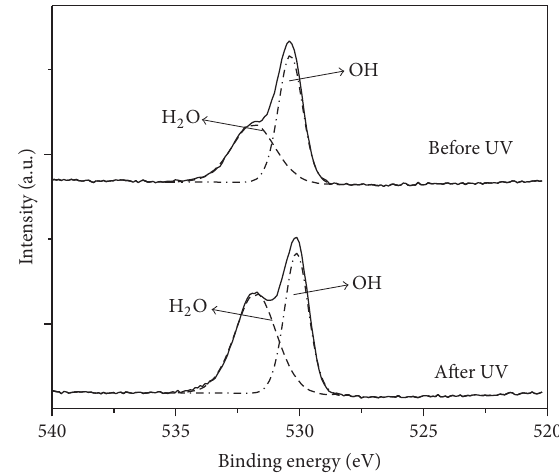
Figure 5: X-ray photoelectron spectroscopy spectra of the O 1s level before and after UV